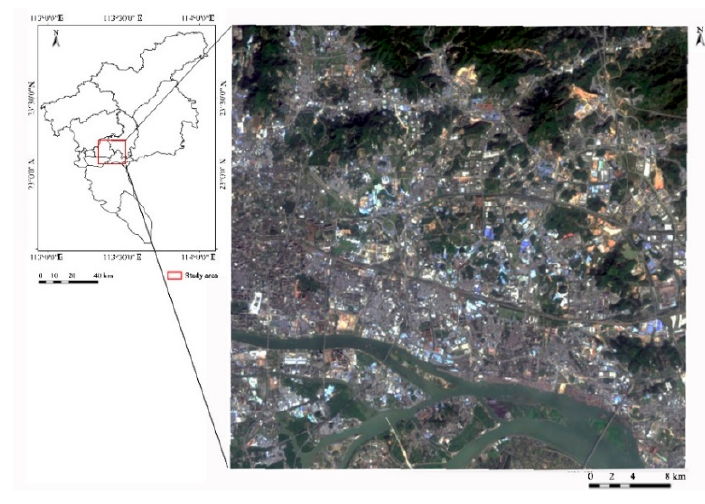
Figure 1. Study area.